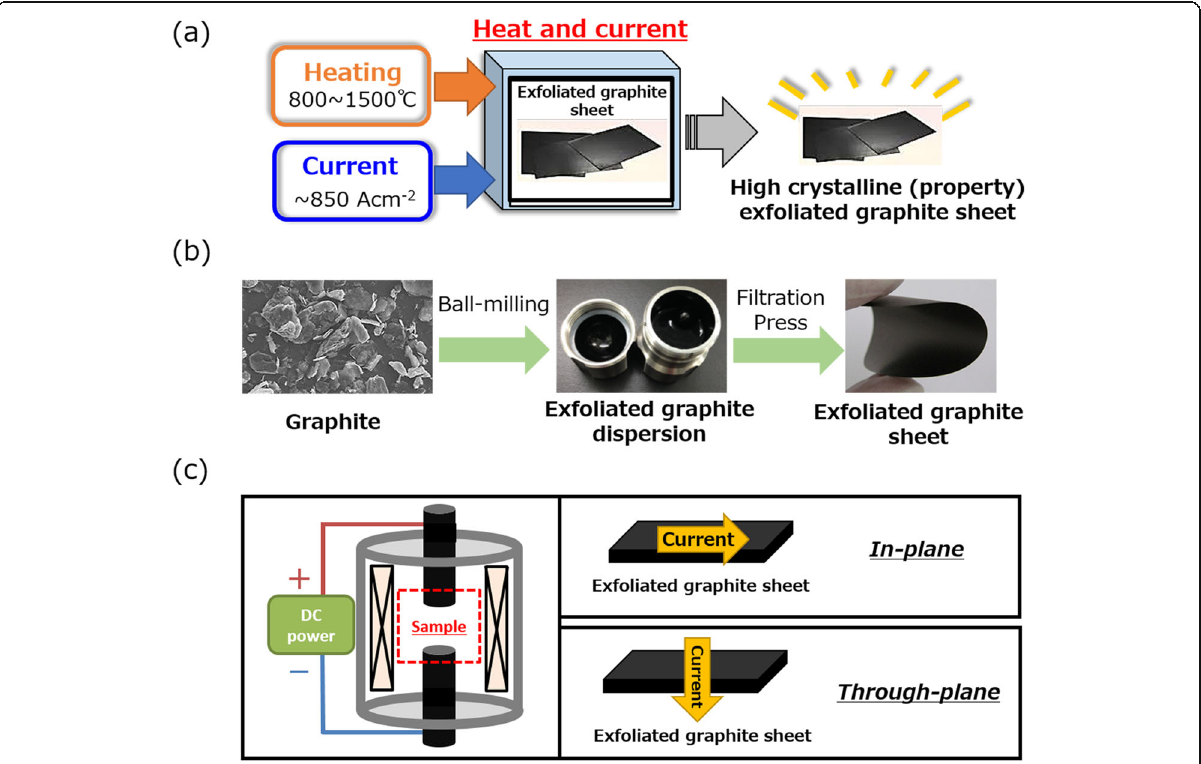
Fig. 1 a Conceptual figure illustrating the heat and current post-treatment for filtrated, exfoliated graphite sheets. b Preparation process of the exfoliated graphite sheet from as-purchased graphite flakes to an exfoliated graphite dispersion and to sheet. c Primary components (chamber, heater, and electrodes) of the treatment apparatus (left) and the two configurations for passing current in-plane or through-plane